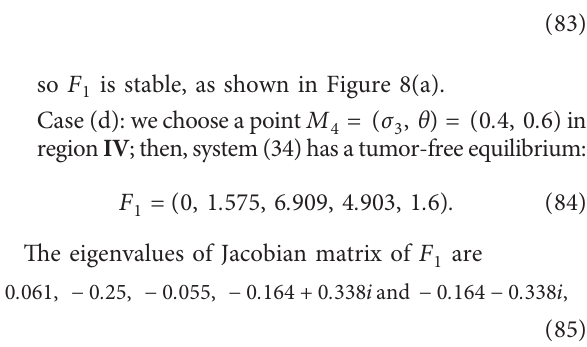
Figure 7: (a) Stability region of F ∗ and Hopf bifurcation curve in θ − σ (b) MAI curve. F is stable in region III and unstable in region IV . (c) The bifurcation diagram of x with respect to θ for fixed σ 1 bifurcation point appears at θ ∗ MAI � 0 . 627. (d) The bifurcation diagrams of x with respect to θ for different σ blue curves represent the stable steady states of system (34), while the red curves represent the unstable steady